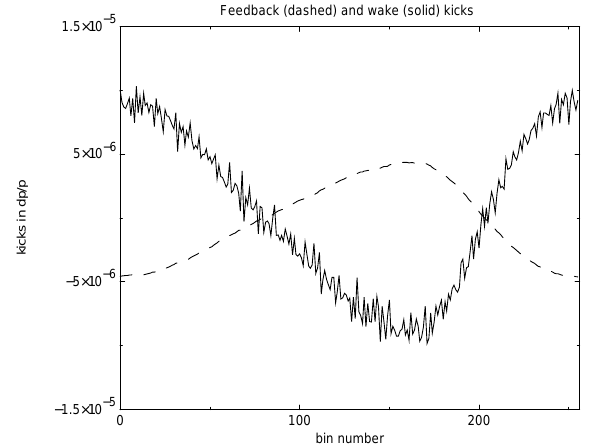
FIG. 4. The kicks from the wake and the feedback. Note that the feedback kicks are just the negative of the wake kicks. FIG. 5. The growth rate of the bunching factor as a function of